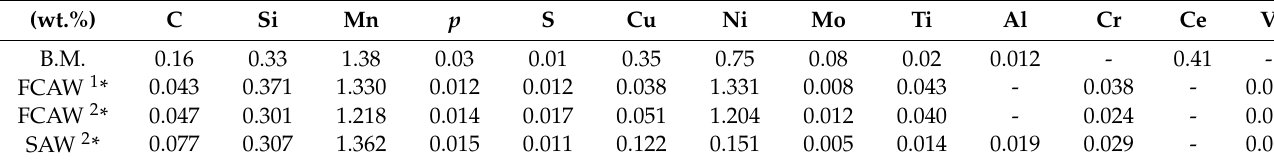
Table 1. Chemical composition of the base metal and weld metal. (wt.%)